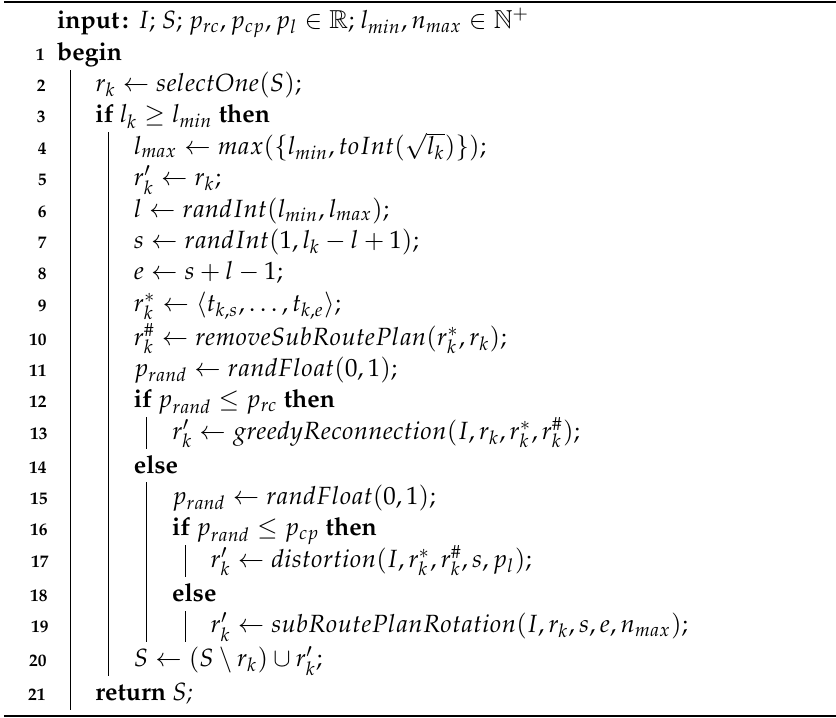
Algorithm 6: subRoutePlan (main algorithm of the sub-route plan